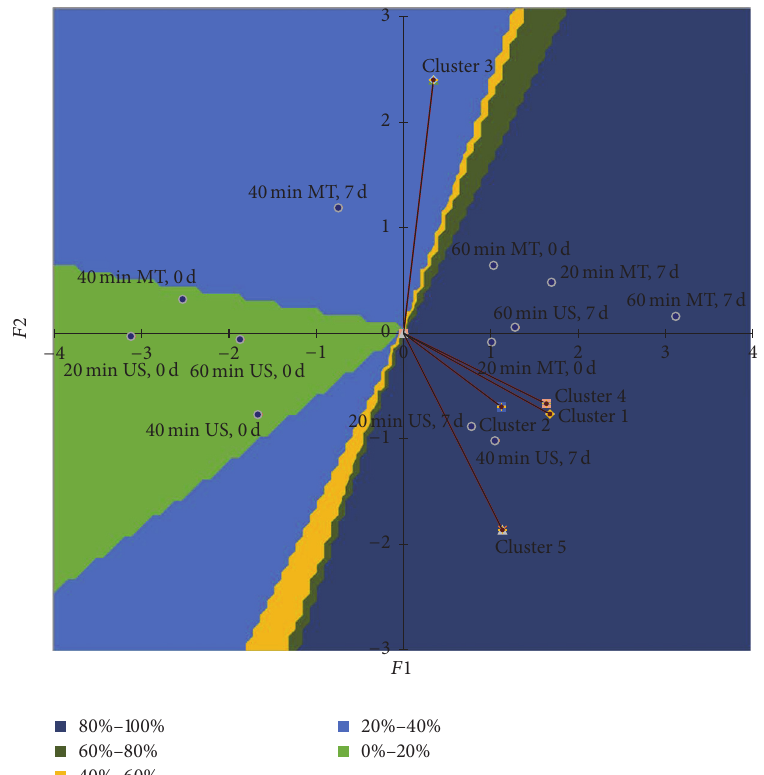
Figure 5: Preferences and satisfaction (%) of beef samples (longissimus dorsi) . MT, marinated traditionally; US, ultrasound; d, storage days at 4 ∘ C; Cluster, segmentation of the consumer judges in groups of similar